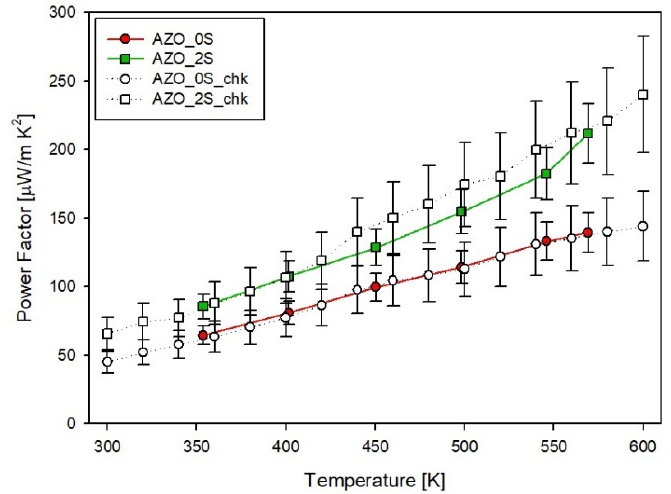
Figure C3. Power factor plotted vs. temperature of AZO_0S and AZO_2S calculated from experimental data obtained with two different setups. Filled symbols are the same as those reported in the plots in the main text, while the open symbols “chk” were obtained with another device.